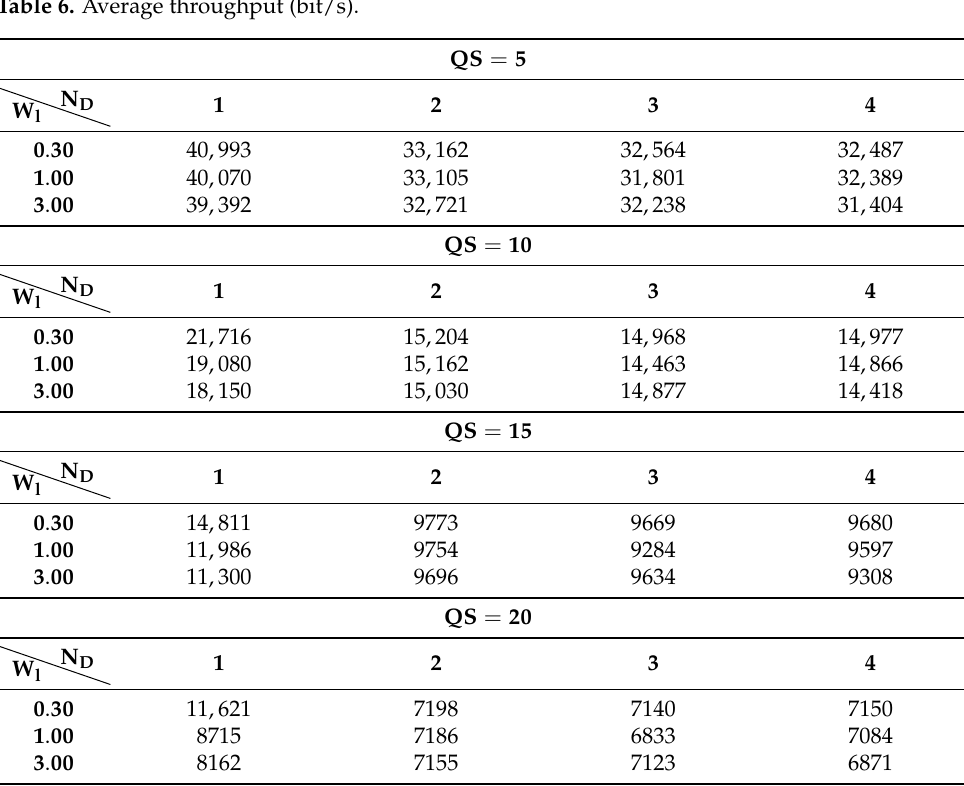
Table 6. Average throughput (bit/s).